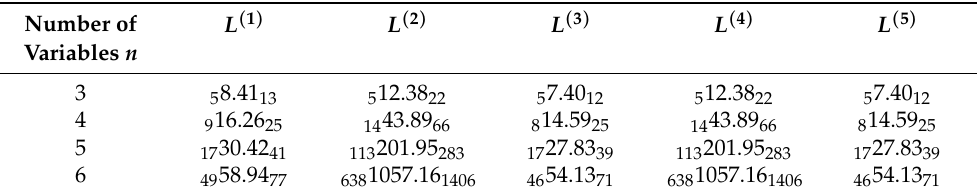
Table 5. Experimental results for Boolean functions—number of realizable nodes. Number